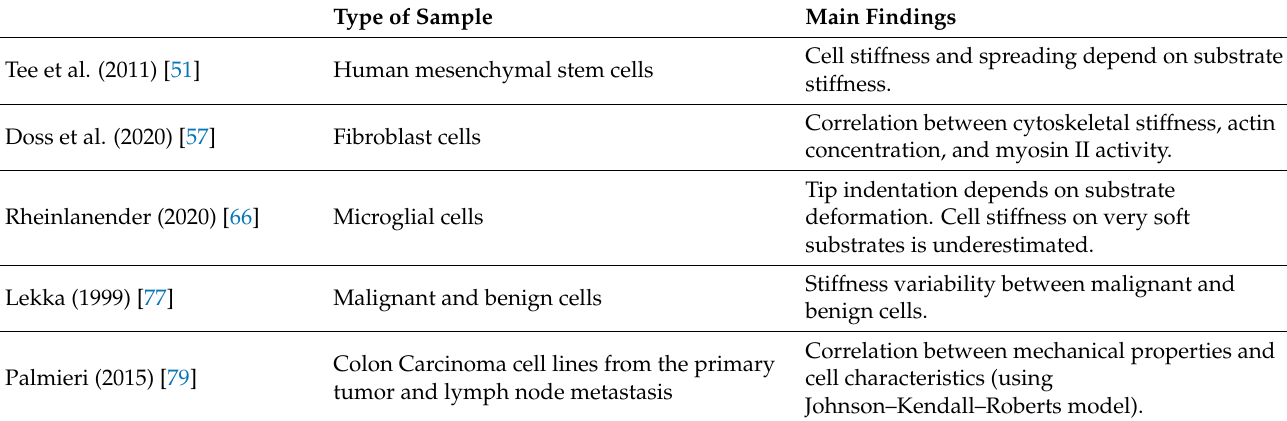
Table 1. Summary of the main papers analyzed in this review.